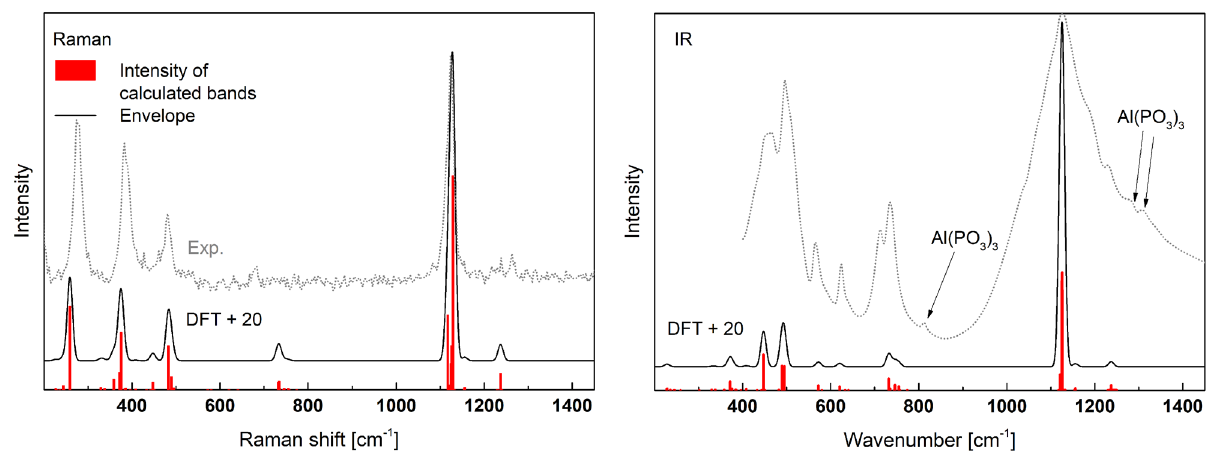
Figure 15. Calculated Raman and IR spectra of α-cristobalite type AlPO 4 shifted by + 20 cm -1 and experimental IR and Raman spectra (Exp.) of the synthesized